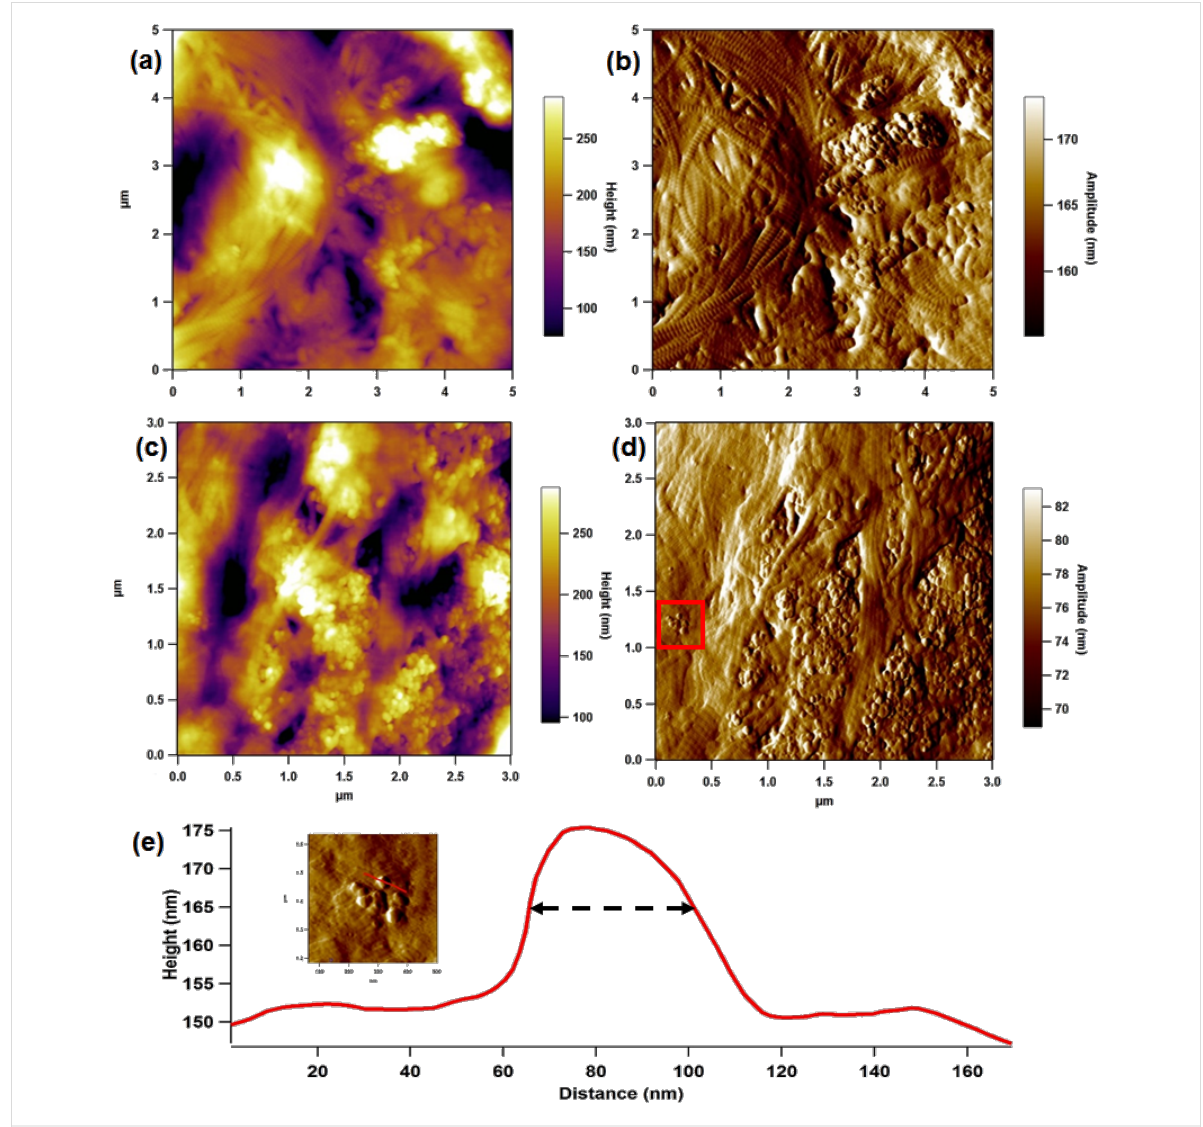
Figure 4: Height (a & c) and amplitude (b & d) images of disperse ink particles in the dermal collagen network. (Inset of (e)) 500 nm image of small cluster of ink particles from the solid red square (e) Line profile showing a particle of 37.5 nm width at half height.